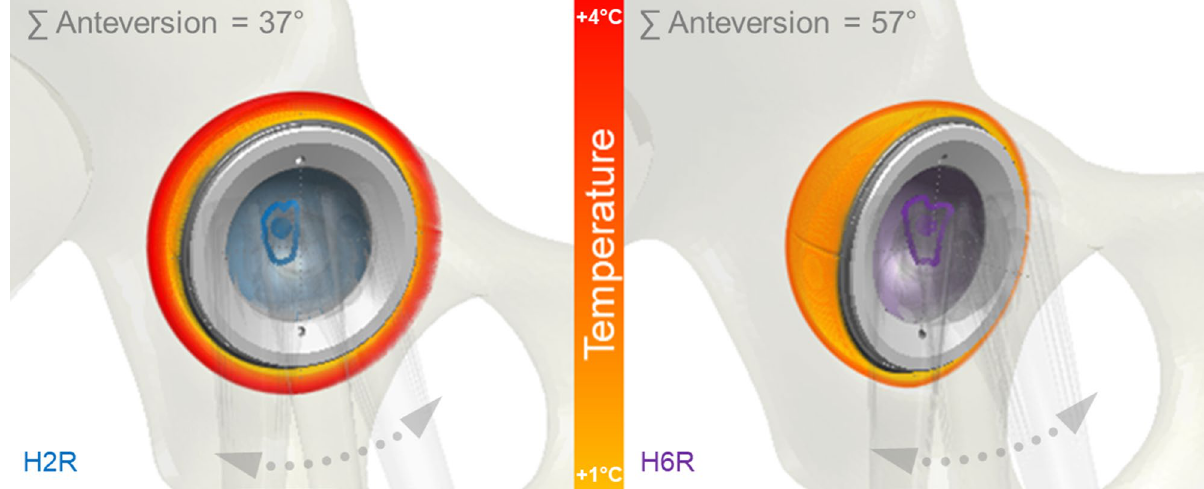
Figure 4. The in vivo measured temperature increase in the artificial joint replacement is determined by the individual implant orientation (∑AV), the resultant size of the joint roofing (A3D) and the position of the contact path in the liner as well as by the average gliding velocity of the